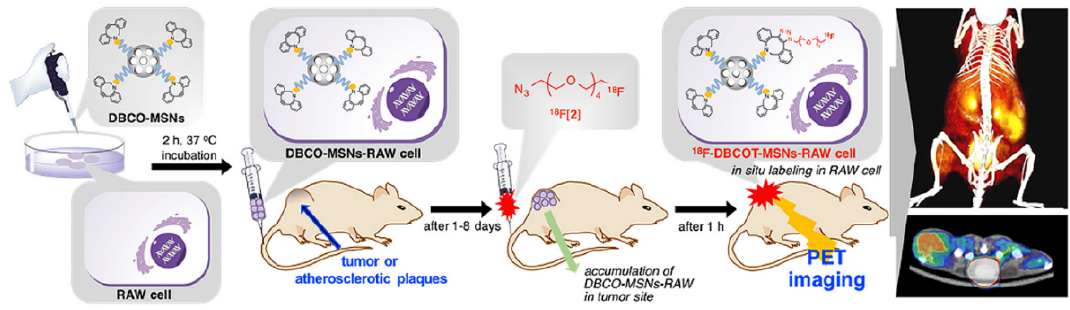
Figure 13. A schematic representation for the design of 18 F-radiolabelled MSNs. Cyclooctyne functionalised MSNs (DBCO-MSNs) were first incubated with RAW cells, with the incubated samples then injected into nude mice bearing a tumour or atherosclerosis plaques. One to eight days later, 18 F-labelled azide was injected into the mice to visualise the tumour / atherosclerotic sites in vivo. Reprinted with permission from reference [152]. Copyright (2019) Elsevier.